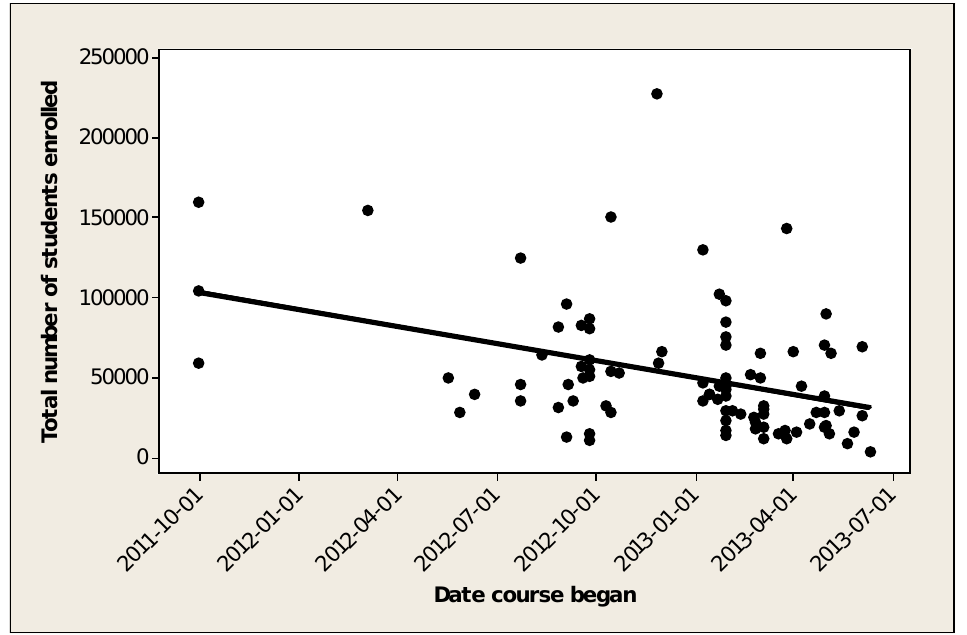
Figure 2 . Scatterplot of total enrolment numbers plotted against course start date for the sampled courses ( n =